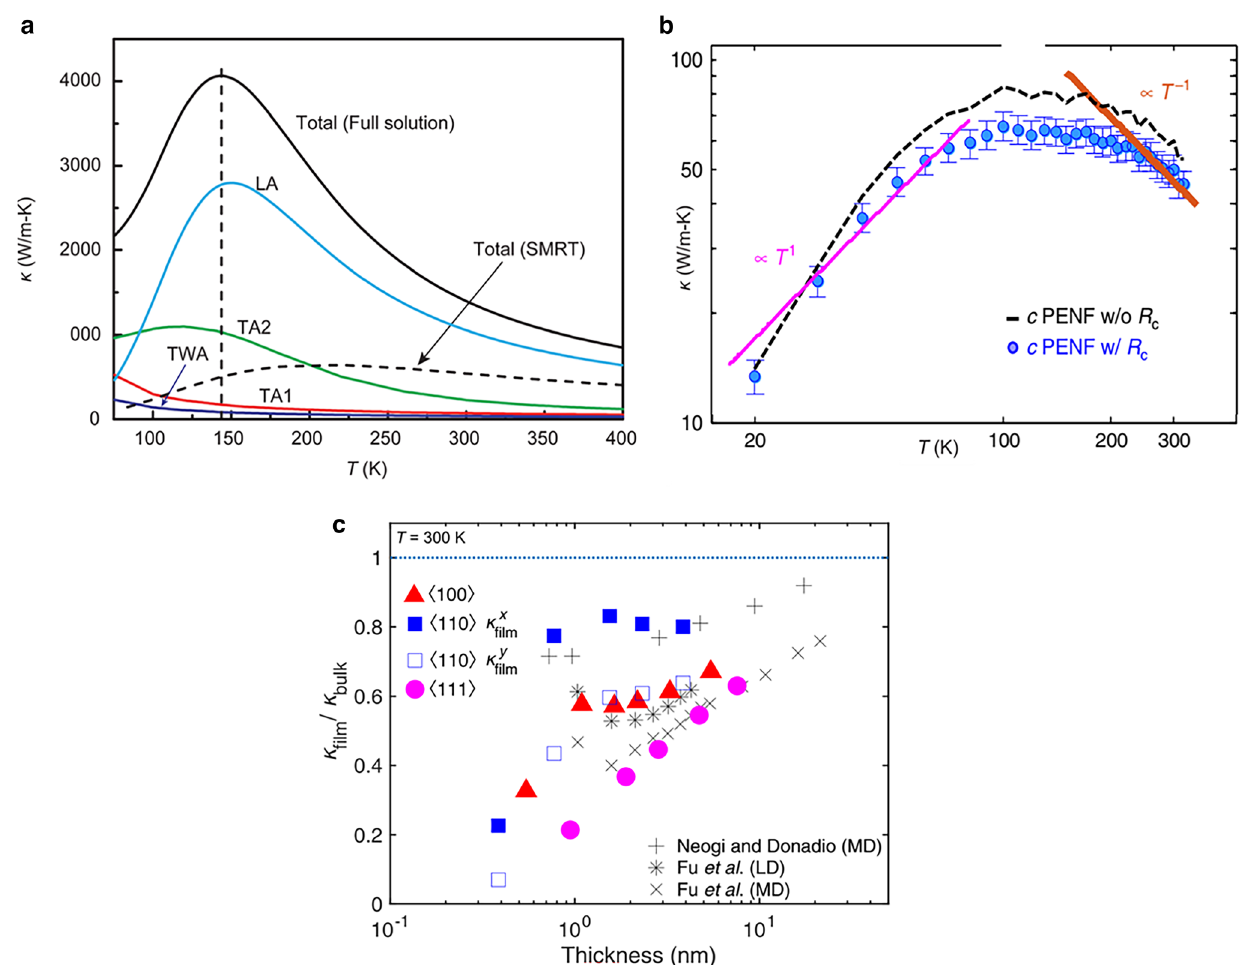
Fig. 3 a Variations of the axial k of an infinite one‑dimensional PE chain as a function of temperature, along with the absolute k contributions from the four acoustic phonon modes and the k values from the single‑mode relaxation‑time model. TA1 and TA2 are the two transverse phonon modes vibrating perpendicular to the chain axis, TWA is the twisting mode and LA is the longitudinal mode. Reproduced with permission from Ref. [31]. Copyright 2017, American Chemical Society. b k of PE nanofiber as function of temperature. Reproduced with permission from